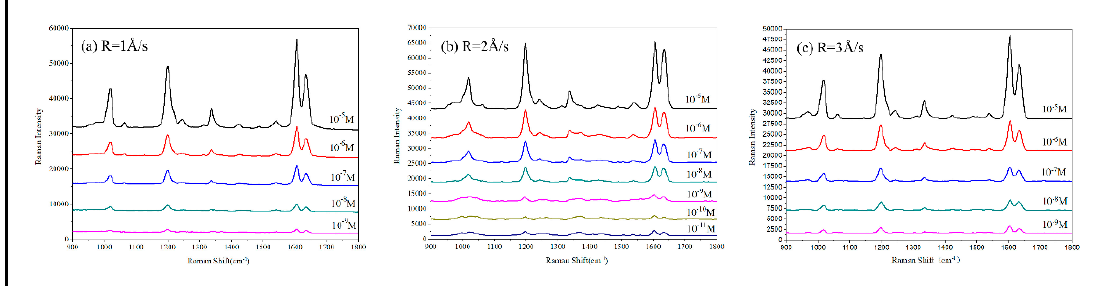
Figure 11. SERS spectra of BPE detected on the AuNRs substrates fabricated with di ff erent deposition rate: ( a ) R = 1 Å / s; ( b ) R = 2 Å / s; ( c ) R = 3 Å /